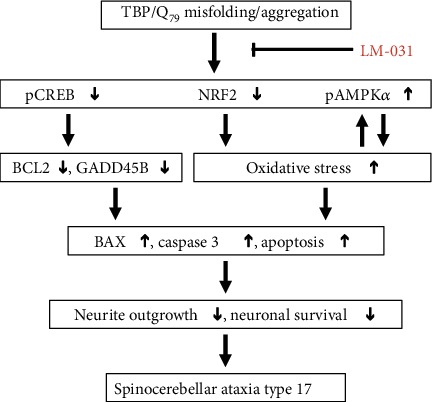
Graphical abstract.